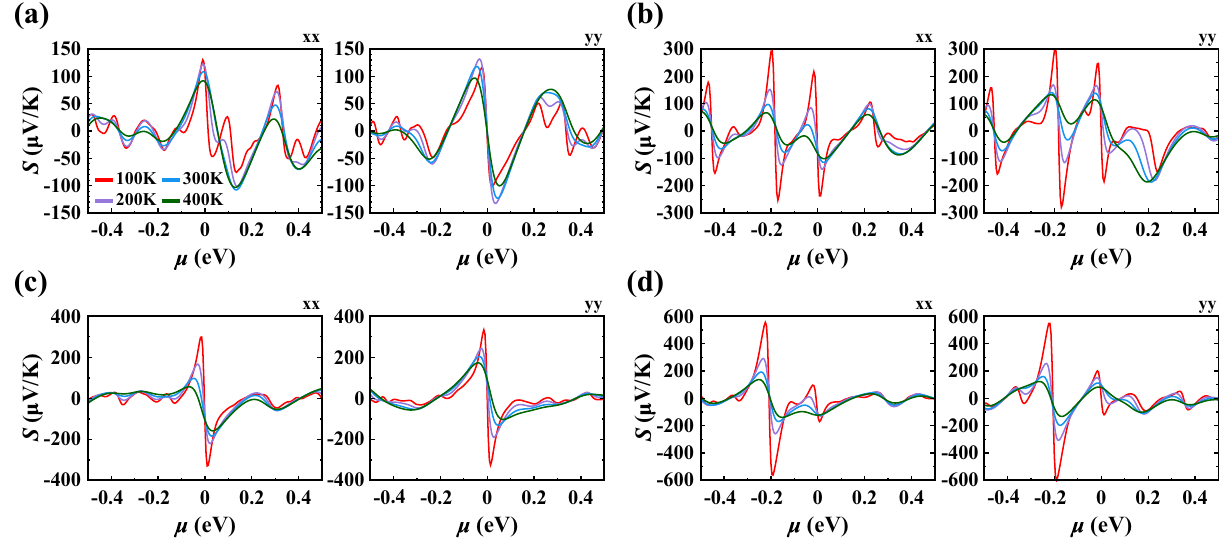
Figure 12. Seebeck coefficient ( S ) calculated as a function of chemical potential ( µ ) at various temperatures along xx and yy lattice directions for ( a ) Te(1) vacancy, ( b ) Te(2) vacancy, ( c ) Te(1)- O 2 substitution with parallel orientation, ( d ) Te(2)- O 2 substitution with parallel